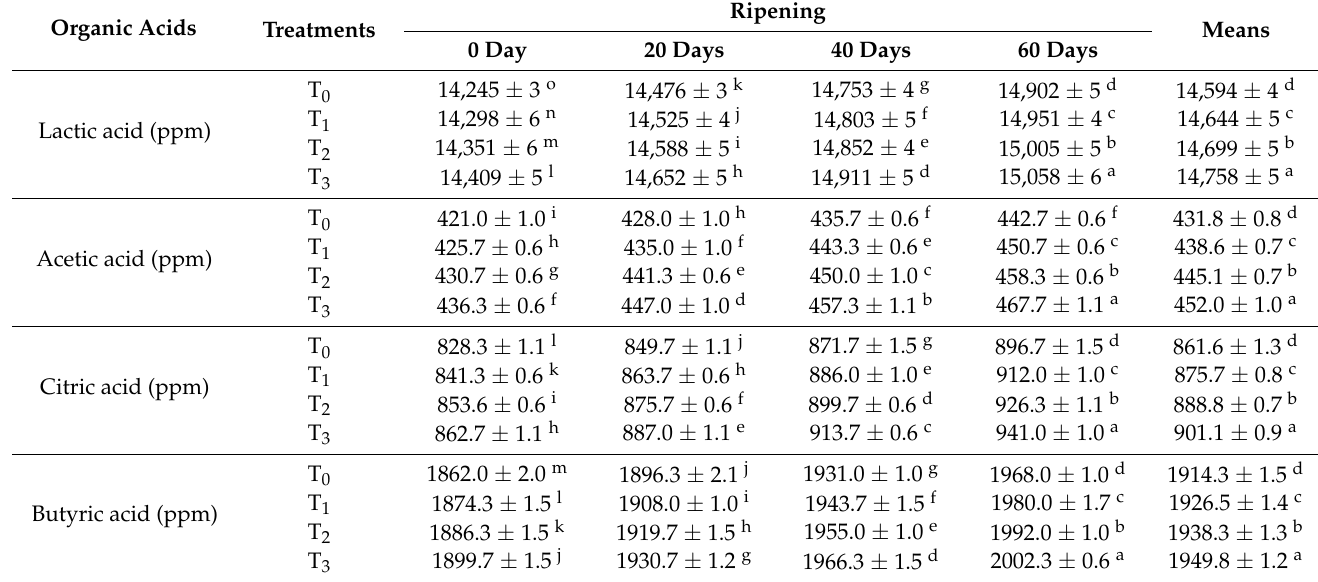
Table 3. Organic acids of all cheese treatments during the ripening period (means ±